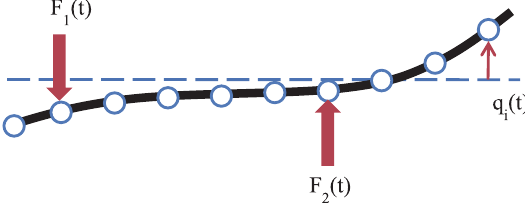
Fig. 1. Discretized, multi-DOF mechanical